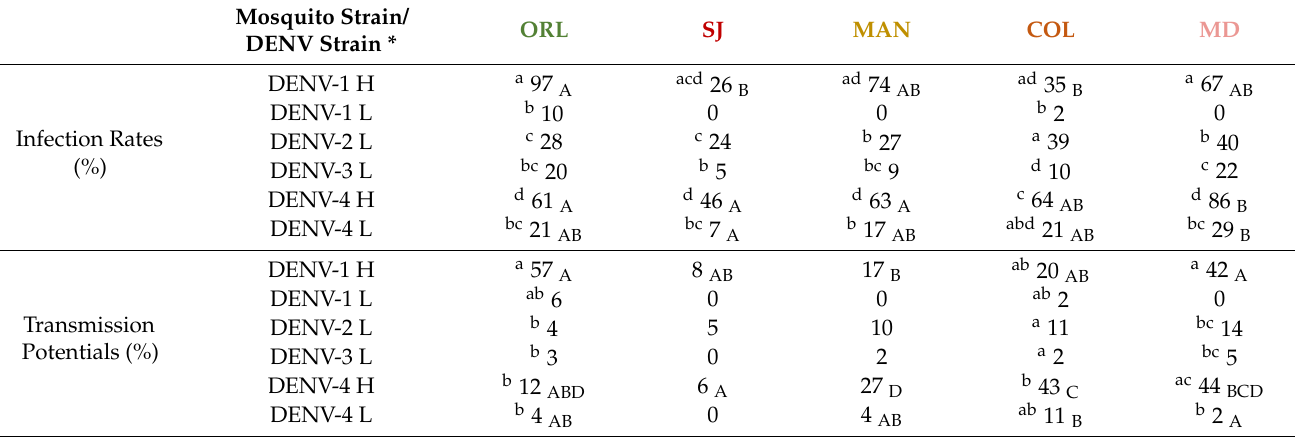
abc Lowercase alphabetical superscripts represent infection rate/transmission potential comparisons across virus strains for each column for the same mosquito strain. Values denoted with different letters (a, b, c, or d) have significantly different infection or transmission potentials. Columns without superscripts had no significant differences between any comparison group. ABC Uppercase alphabetical subscripts represent infection rate/transmission potential comparisons across mosquito strains for each row for the same virus strain. Values with different letters (A, B, C, or D) have significantly different infection or transmission potentials. Rows without subscripts had no significant differences between any comparison group. * ORL was the most pyrethroid-susceptible, MAN was the second most pyrethroid-susceptible, COL was moderately pyrethroid resistant, MD was the second most pyrethroid-resistant and SJ was the most pyrethroid-resistant, based on kdr genotype